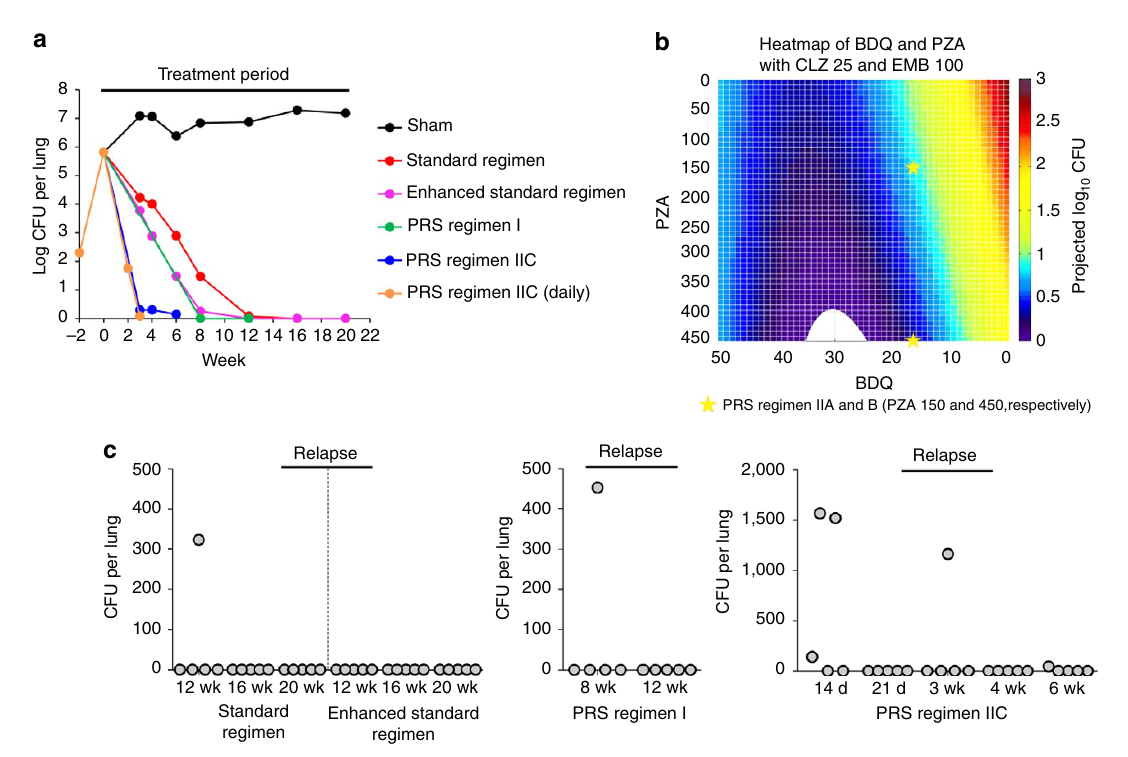
Figure 5 | Long-term efficacy and relapse study. ( a ) M. tuberculosis burden in the lung over the course of infection and treatment period, where mice were sham-treated or treated with the Standard Regimen, Enhanced Standard Regimen or PRS Regimen I or IIC 5 days (Monday—Friday) a week starting at Week 0. The PRS Regimen IIC (daily) group was treated daily for 14 days. Data transformation as log 10 ( x þ 1) with x being the actual CFU was used for graphing purpose. ( b ) Heatmap for PRS Regimen II with CLZ and EMB dose at 25 and 100mgkg (cid:2) 1 , respectively, indicating that the optimal doses of BDQ and PZA were 30 and 450mgkg (cid:2) 1 , respectively. The white zone around BDQ 30mgkg (cid:2) 1 at the bottom of the map corresponds to CFU projected to be 0 or below. ( c ) Relapse in the lung 3 months after completion of treatment with the PRS Regimen I or IIC or control regimens (Standard Regimen or Enhanced Standard Regimen) daily (d) or 5 days per week (wk) for the duration indicated. Differences in time to relapse-free cure between the Standard Regimen and the PRS regimens administered at the same frequency (5 days per week) were statistically significant ( P ¼ 0.002 versus PRS Regimen I